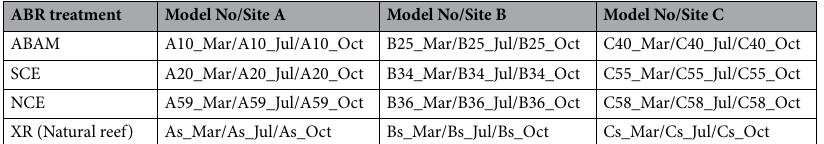
Table 2. Samples collected from the surface of the ABRs with the three different treatments and the natural reef sediment (XR). ABAM indicates the ABR model made of specific cement supported with bioactive materials, SCE indicate the control ABR model made of specific cement with no supplement, NCE indicates the negative control model made of normal cement with no added bioactive materials, and XR represent the natural reef samples (As, Bs,